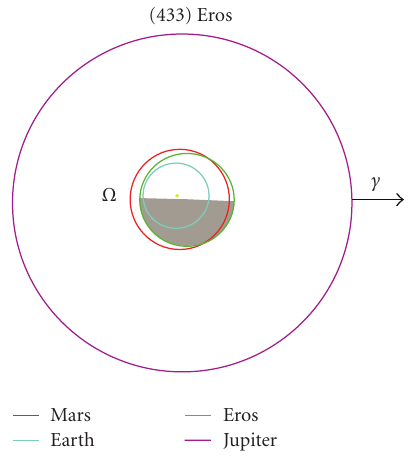
Figure 2: Orbit of asteroid Eros.